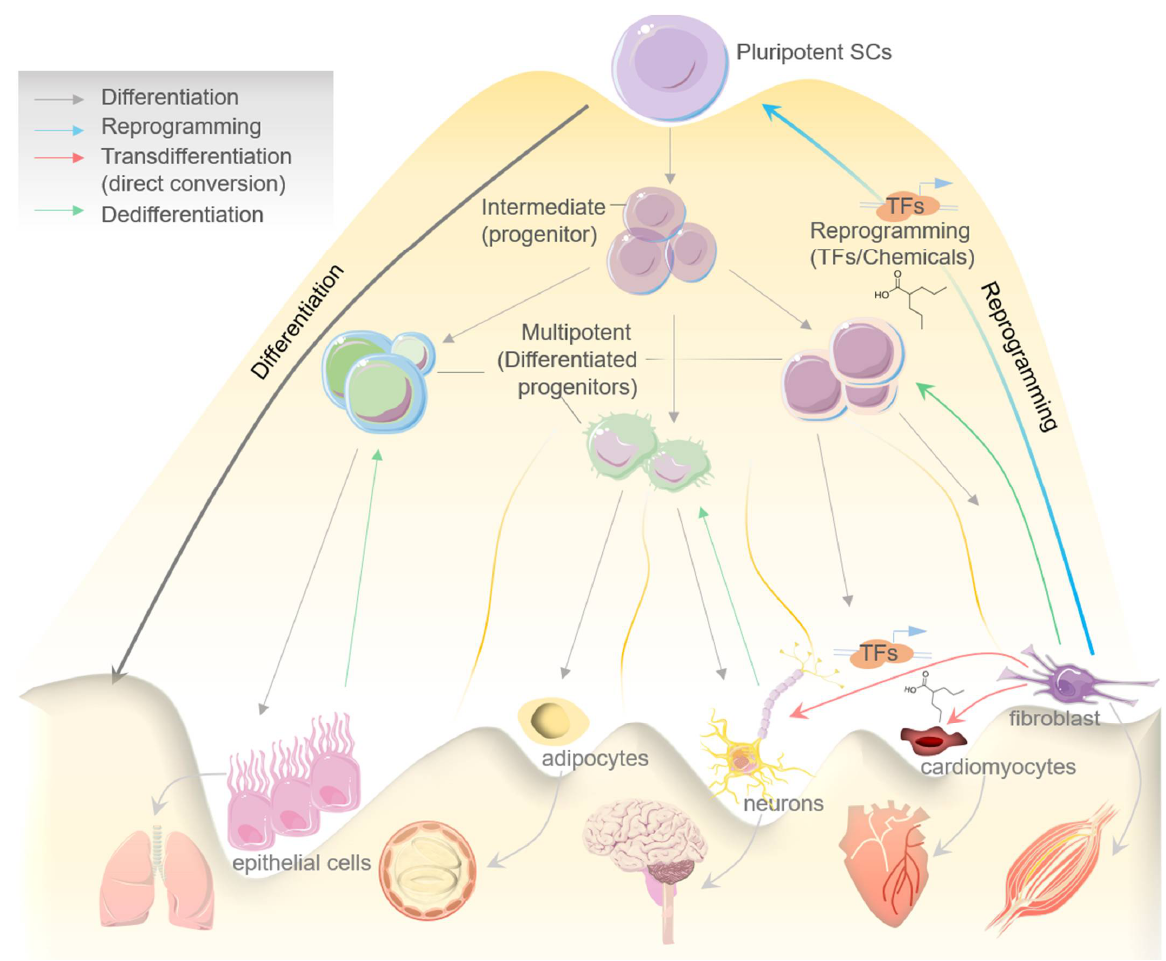
Figure 1. Schematic diagram showing processes of differentiation, reprogramming, transdifferentiation (direct conversion), and dedifferentiation in determining the cells fate, while dedifferentiation represents a reverse step in this process. Model exhibiting the pluripotent stem cells differentiation to intermediate progenitor SCs, then to multipotent SCs/differentiated progenitors, and eventually to mature tissue-specific specialized cells. Reprogramming indicates reverting back a mature cell into induced pluripotent stem cells (may consist of an intermediate step/cell population) with the help of specific TFs and chemicals/small molecules. Transdifferentiation represents the direct conversion of a specialized mature cell into another cell type by the help of specific TFs and chemicals/small molecules.